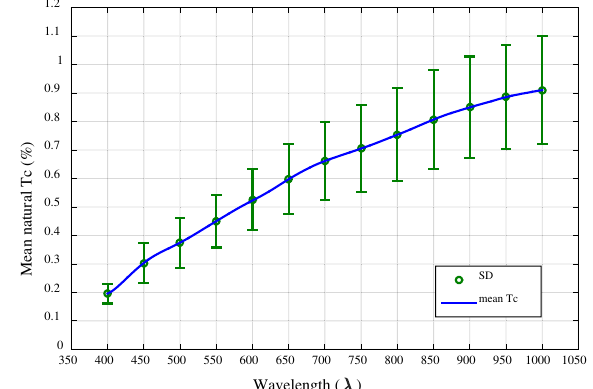
Fig. 2. Collimated transmittance spectrum of rat skeletal muscle (mean of 15 samples; sample thickness ¼ 500 (cid:5) 50 (cid:1) m).